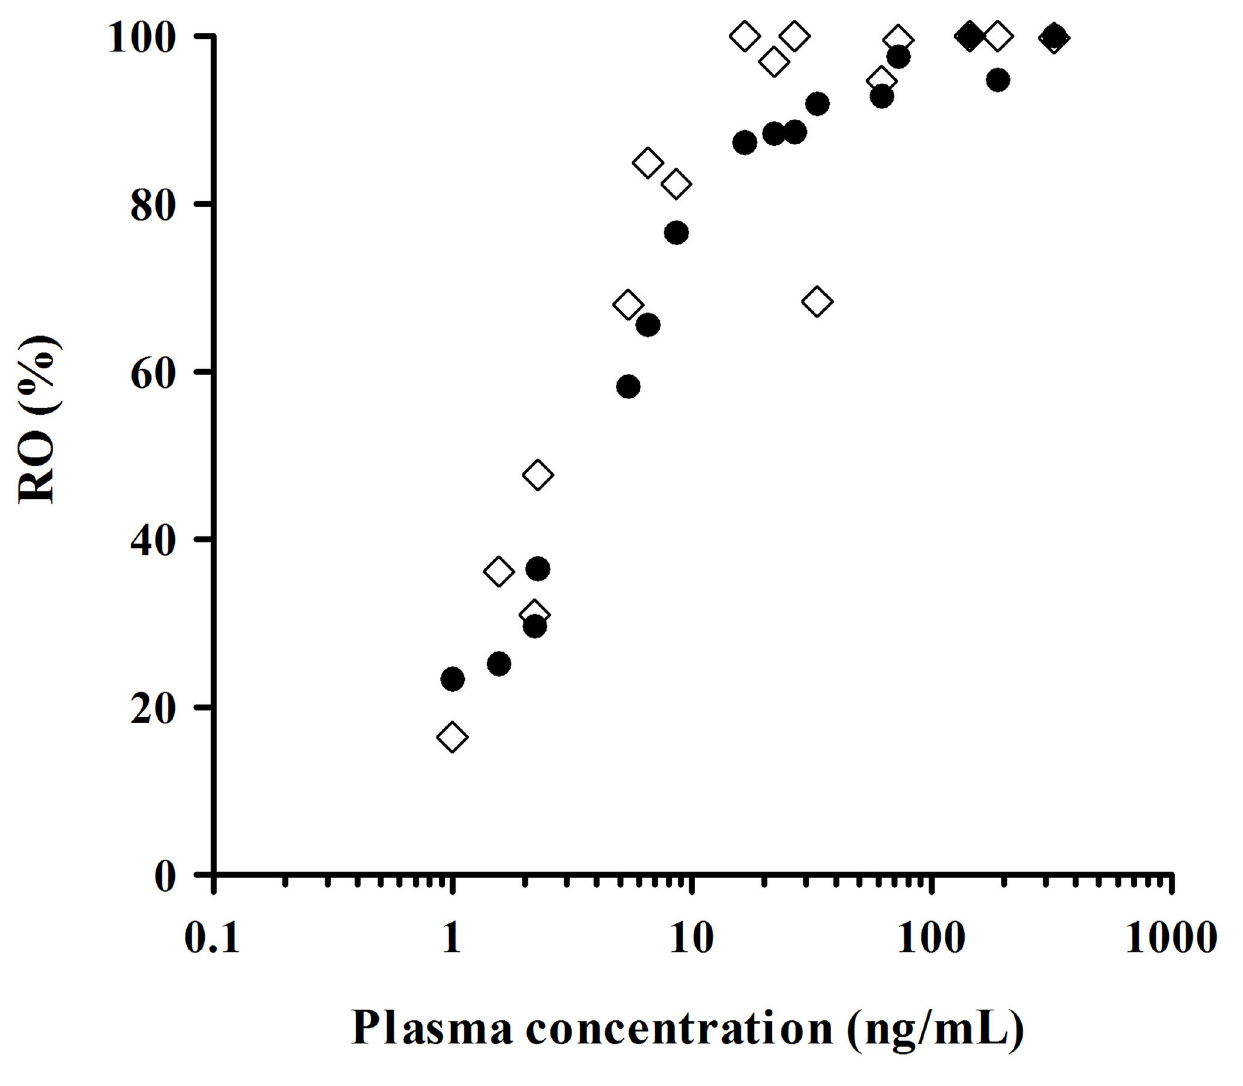
Figure 5. Relationship between rat 5-HT determined at 4 hours after oral administration of E2110 at a dose ranging from 0.3 to 10 mg/kg. Symbols represent individual data from all dose levels (n = 4/dose